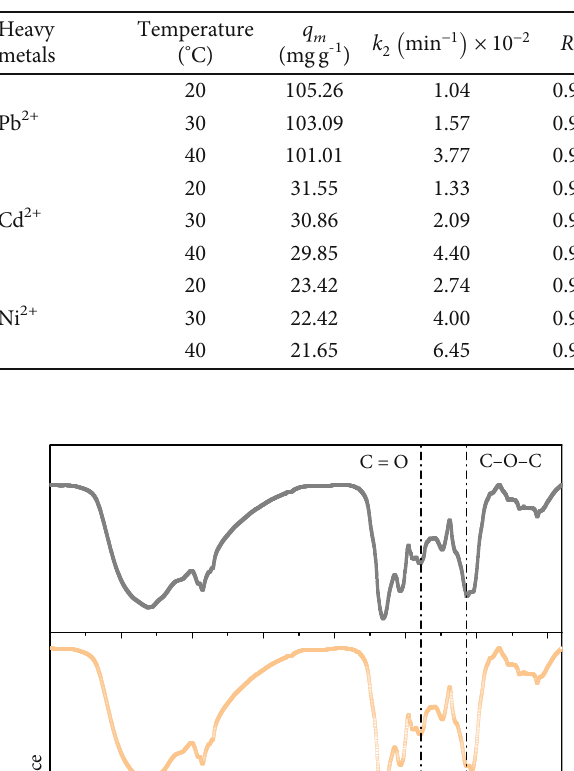
Table 5: Parameters of pseudo-second-order kinetics model. Table 4: Parameters of Dubinin – Radushkevich